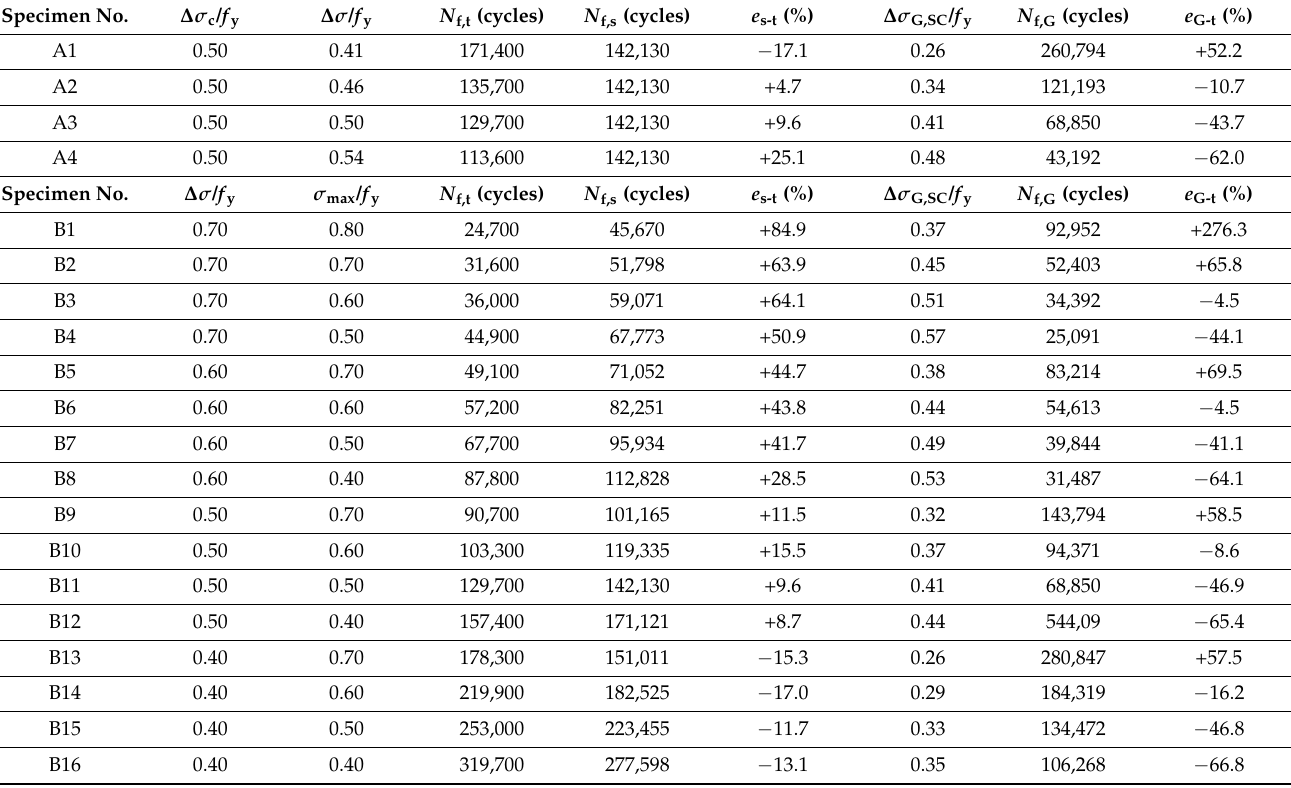
Table 3. Fatigue test results of the Q460C steel notched plates.